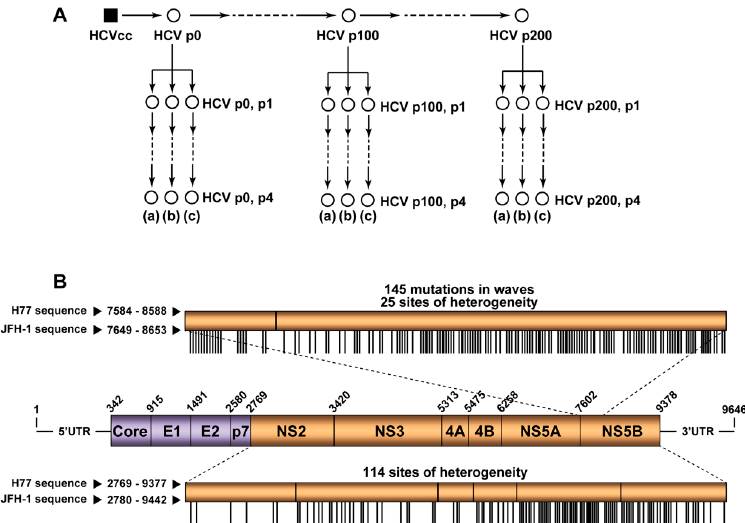
Figure 1. Experimental design, and hepatitis C virus (HCV) genome analysis. ( A ) Clonal HCV population HCVcc prepared by transcription of plasmid Jc1Luc [28], followed by RNA electroporation into Huh-7 Lunet cells, was amplified to produce HCV p0, and the population subjected to 200 passages in Huh-7.5 cells, as described [17–19]. The initial population HCV p0 and the populations at passages 100 (HCV p100) and 200 (HCV p200) were passaged four additional times in Huh-7.5 cells in triplicate (replicas (a), (b), (c)). The mutant spectrum of each of the populations (represented by empty circles) was analyzed. ( B ) Scheme of the HCV genome, encoded proteins and genomic regions analyzed; residue numbering is according to isolate H77. In the boxes depicted above and below the genome, the equivalence of nucleotide residue numbers for isolates H77 and JFH-1 is indicated. The upper box corresponding to the NS5A-NS5B-coding region indicates the positions involved in mutational waves within residues 7584 to 8588 (H77 numbering) (vertical lines). Frequency levels are described in Section 2 and indicated in Table S1 (Supplementary Material at the end of the manuscript). The bottom box corresponding to the NS2-NS5B-coding region indicates the sites of heterogeneity determined by Sanger sequencing (see also Section 2). Results are from [19], and the mutations under study are compiled in Tables S1 and